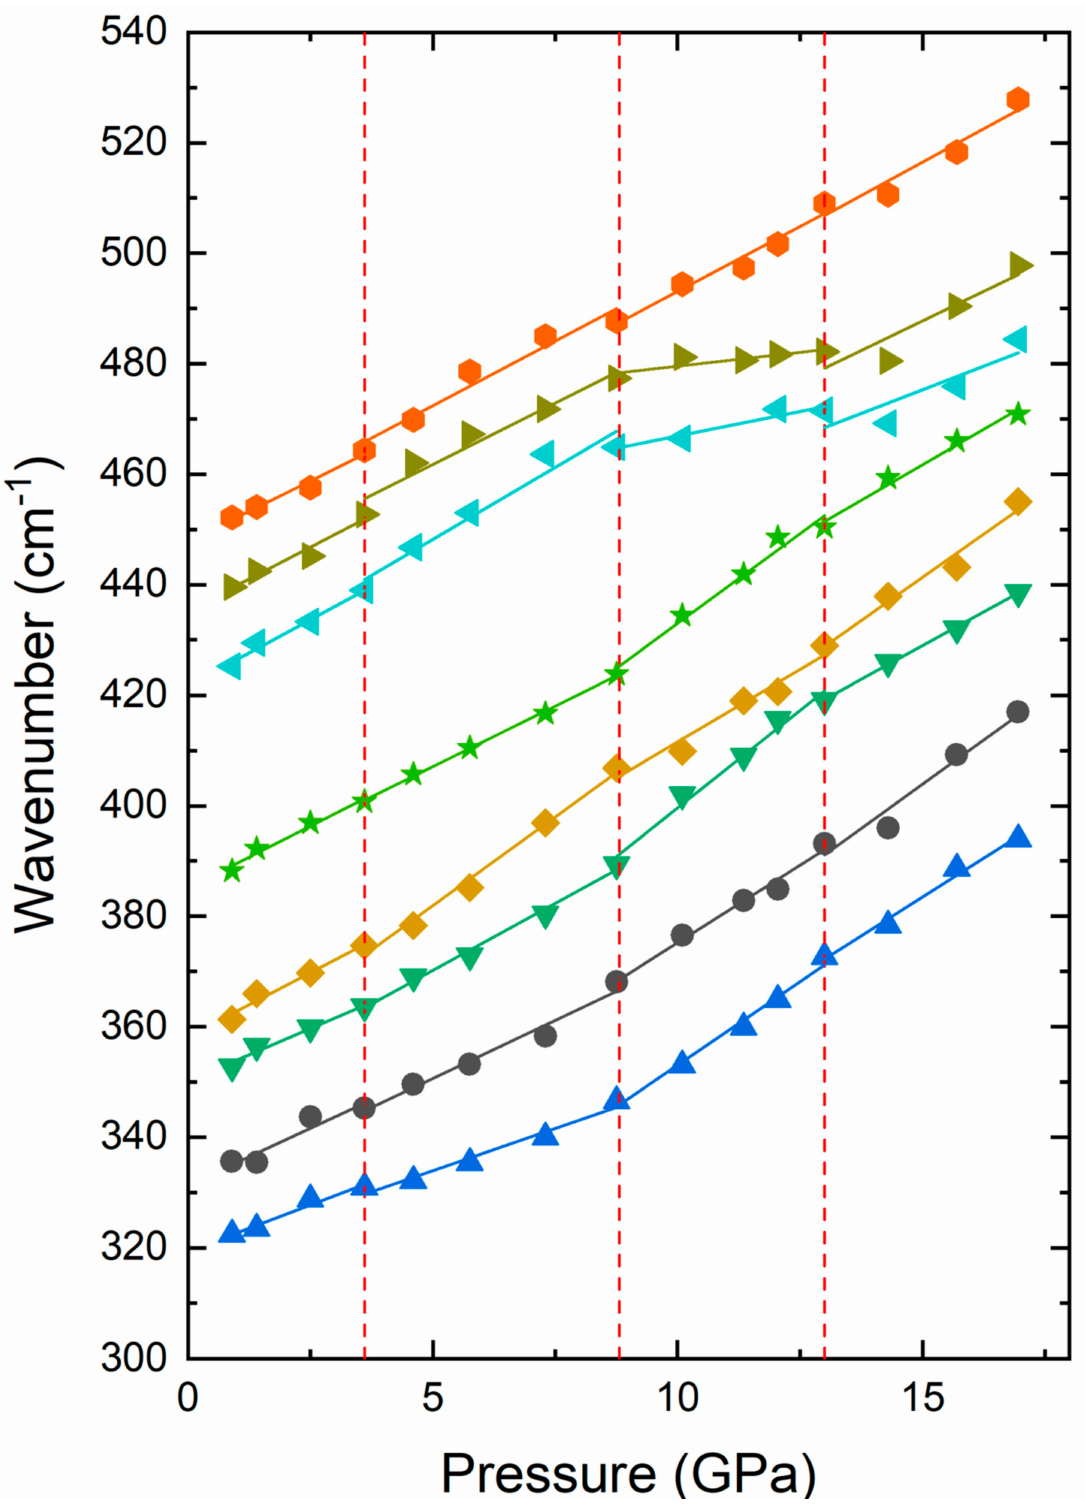
Figure 4. Pressure dependence of IR modes obtained from experiments. Only IO 3 internal bending modes are shown. Vertical lines indicate suggested transition